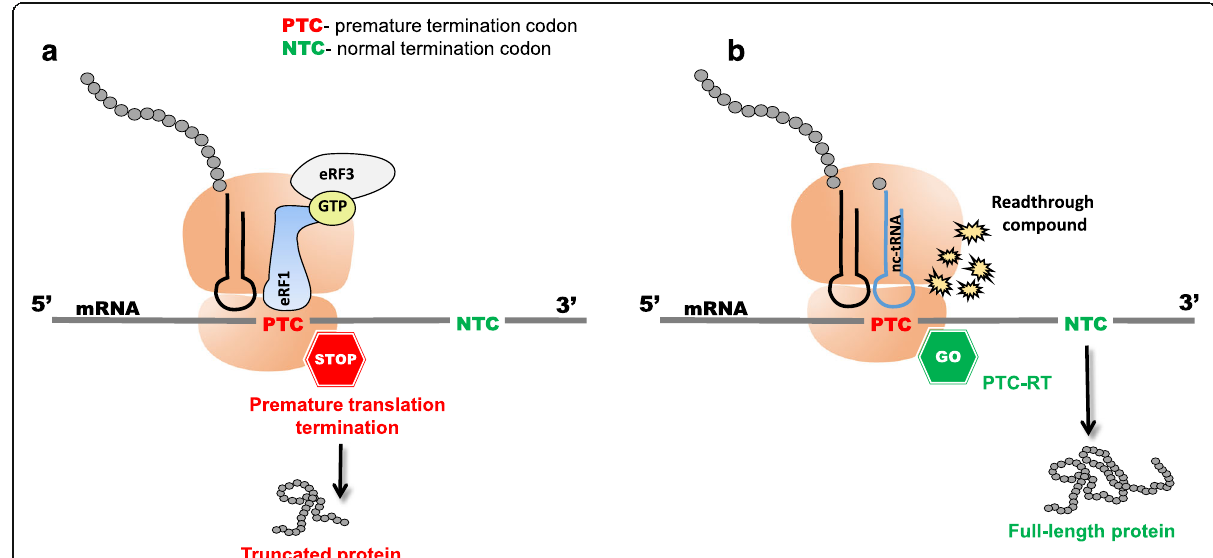
Fig. 1 PTC-RT process. a Ribosome encounters premature termination codon (PTC); the site is recognized by the translation termination machinery and the polypeptide elongation is prematurely terminated. b After addition of readthrough compound, translational machinery decodes PTC (PTC is recognized by nc- tRNAs), and translation continues until the normal termination codon (NTC). It allows translating a full-length protein. The NMD surveillance mechanism may detect and degrade PTC-bearing transcripts. If the NMD process is inhibited, very low levels of the full-length protein can be present even in the absence of stimulating agents, as the result of the endogeneous suppression of